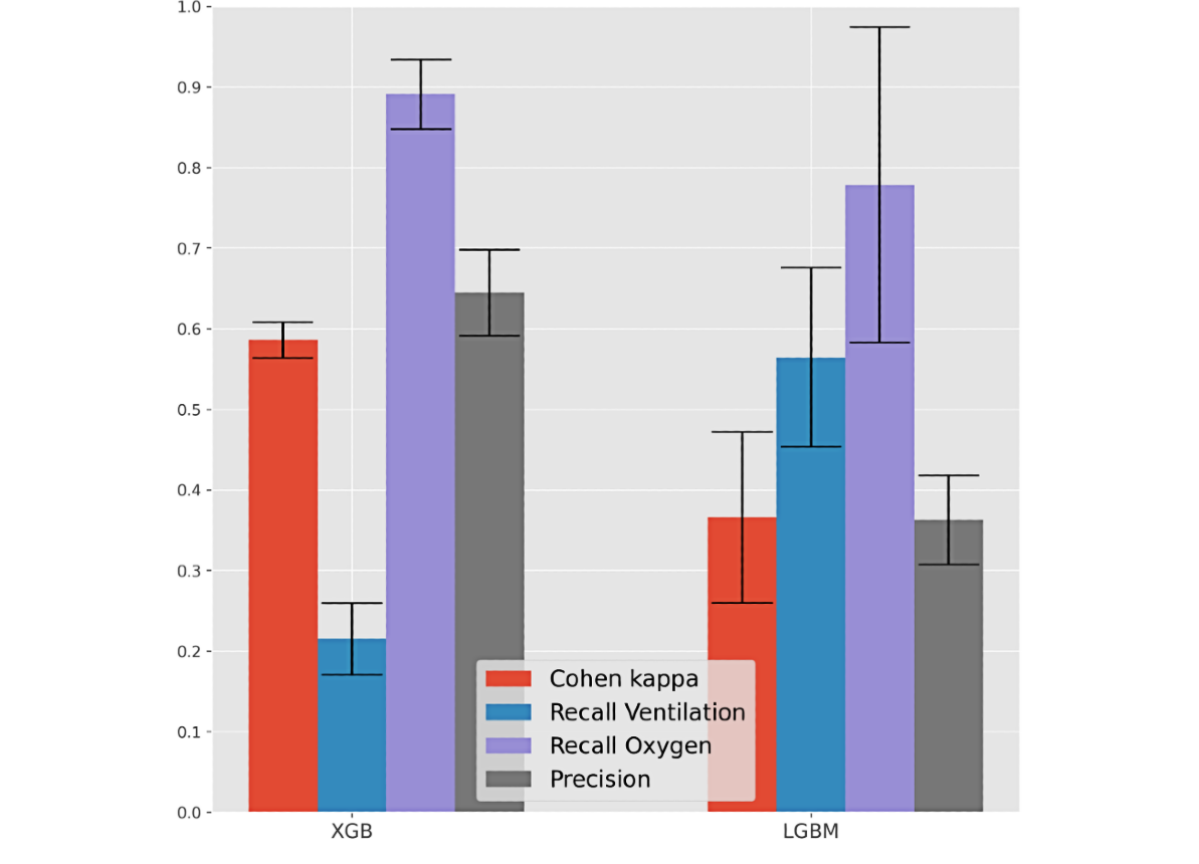
Figure 8. Predictability of respiratory support needs—assisted ventilation, oxygen therapy, and combined support—for hospitalized individuals with SARS-CoV-2. Performance of the best F1 predictor (right) and recall-oriented predictor (left) is shown. XGB: XGBoost, LGBM: LightGBM.